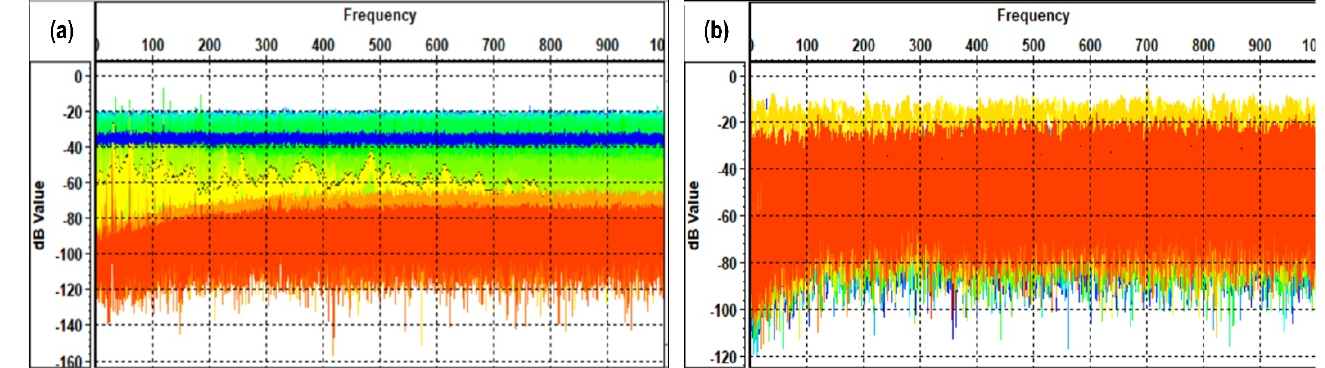
Figure 2. ( a ) All traces of the dB spectrum graph display of the DAS data (blue shows the averaged amplitude spectrum over the entire section; the background coherent noise domain is shown in green; orange—the tail part of the record, close to the bottom of the well; the yellow color on the spectrum shows the events we are interested in). ( b ) The right graph shows the amplitude-frequency spectrum representing the region of interest, depicted in Figure 1 as a red rectangle.